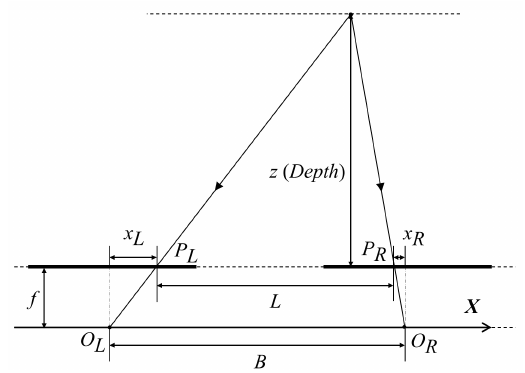
Figure 2 . A schematic diagram of binocular stereo vision.